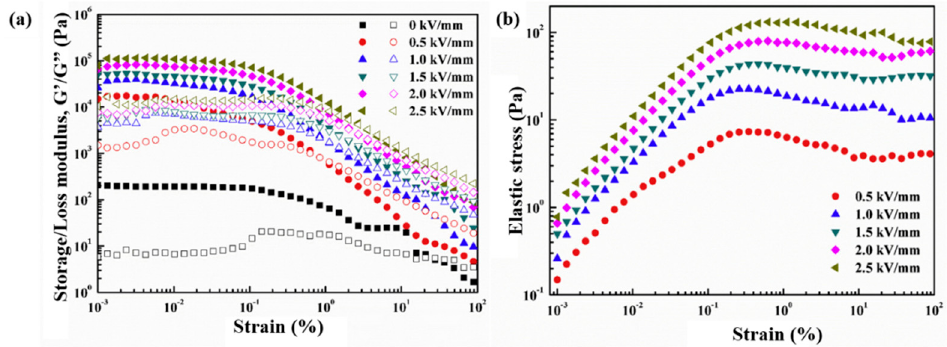
Figure 12. ( a ) Strain amplitude sweep test (closed symbol: G ′ , open symbol: G ″ ) and ( b ) elastic stress ( τ′ = G ′γ ) as a function of strain of PS/PANI based ER fluid (10 vol %) (Piao et al. [61], © Elsevier, 2017). The angular frequency sweep tests are usually carried out with a constant γ within the γ LVE . Figure 13a gives the angular frequency dependence of G ′ and G ″ for a SiO 2 /PPy-based ER suspension for different E s at a fixed strain of 0.004%. Without an electrical field, G ′ and G ″ show similar values and increase with increasing angular frequency. When an electric field is applied, G ′ is much higher than G ″ and shows a relatively stable value over the entire frequency range, suggesting that ER fluids become more solid-like with an input E . Moreover, the stress relaxation property can be estimated from a frequency sweep test. Figure 13b presents the relaxation modulus ( G ( t )) as a function of time. The G ( t ) was estimated from the measured G ′ ( ω ) and G ″ ( ω ) values in Figure 13a using the Schwarzl equation of Equation (8) [113]: